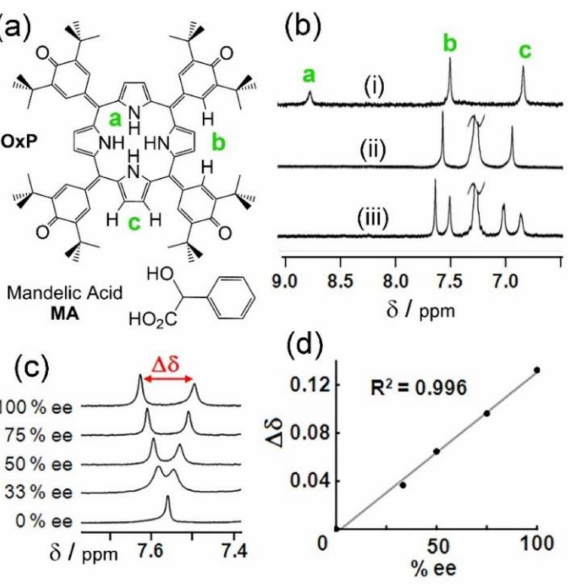
Figure 2. ( a ) Structure of the achiral OxP host and chiral mandelic acid MA with analytically impor- tant protons labelled a–c. ( b ) 1 H-NMR spectra of (i) OxP , (ii) OxP in the presence of 9.3 equivalents of ( rac ) - MA , and (iii) OxP in the presence of 8.8 equivalents of ( R ) - MA . ( c ) OxP quinonoid proton resonance (labelled b) in solution with MA at different enantiomeric excesses. ( d ) Correlation be- tween ee and ∆ δ for spectra shown in (c). Adapted with permission from ref. [42]. Copyright 2009 American Chemical